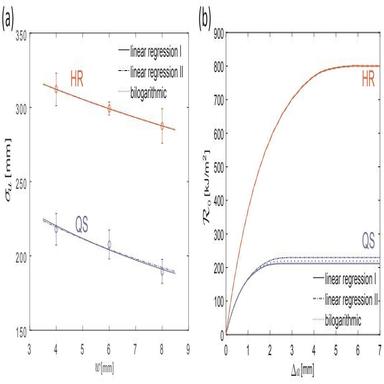
(a) Size effect law and (b) R-curves for QS and HR loading in tension.